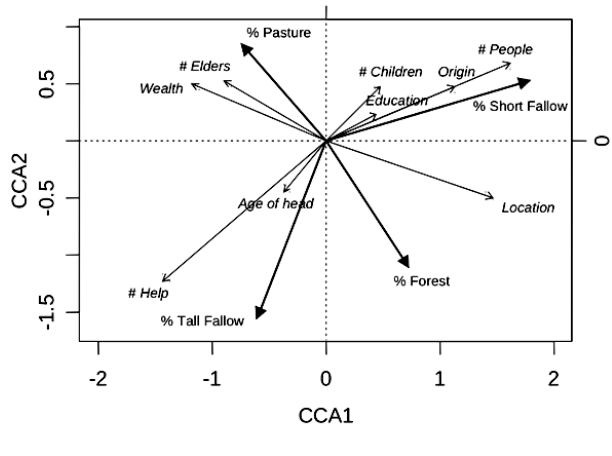
Fig. 3 . Biplot of canonical correspondence analysis between land cover and demographic characteristics at the household level. The axes are linear combinations of the demographic explanatory variables in italics (e.g., # Elders). The relationship between the explanatory variables and the axis can be estimated by drawing a perpendicular line from the tip of the vector to each axis. The relative importance of the explanatory variables on the canonical axes can be estimated by the length and position of the vectors. The bold arrows position the land cover dependent variables (e.g., % pasture) on the 2D space to help visualize the degree to which the explanatory variables explain the variation in the dependent variables. Origin represents whether the interviewee’s family is originally from the Darién province (value of 1; otherwise value of 0). Location represents whether the interviewee lives closer to the Highway (Site 1; value of 0) or further (Site 2; value of 1). # Help represents the number of people available to help work the land.